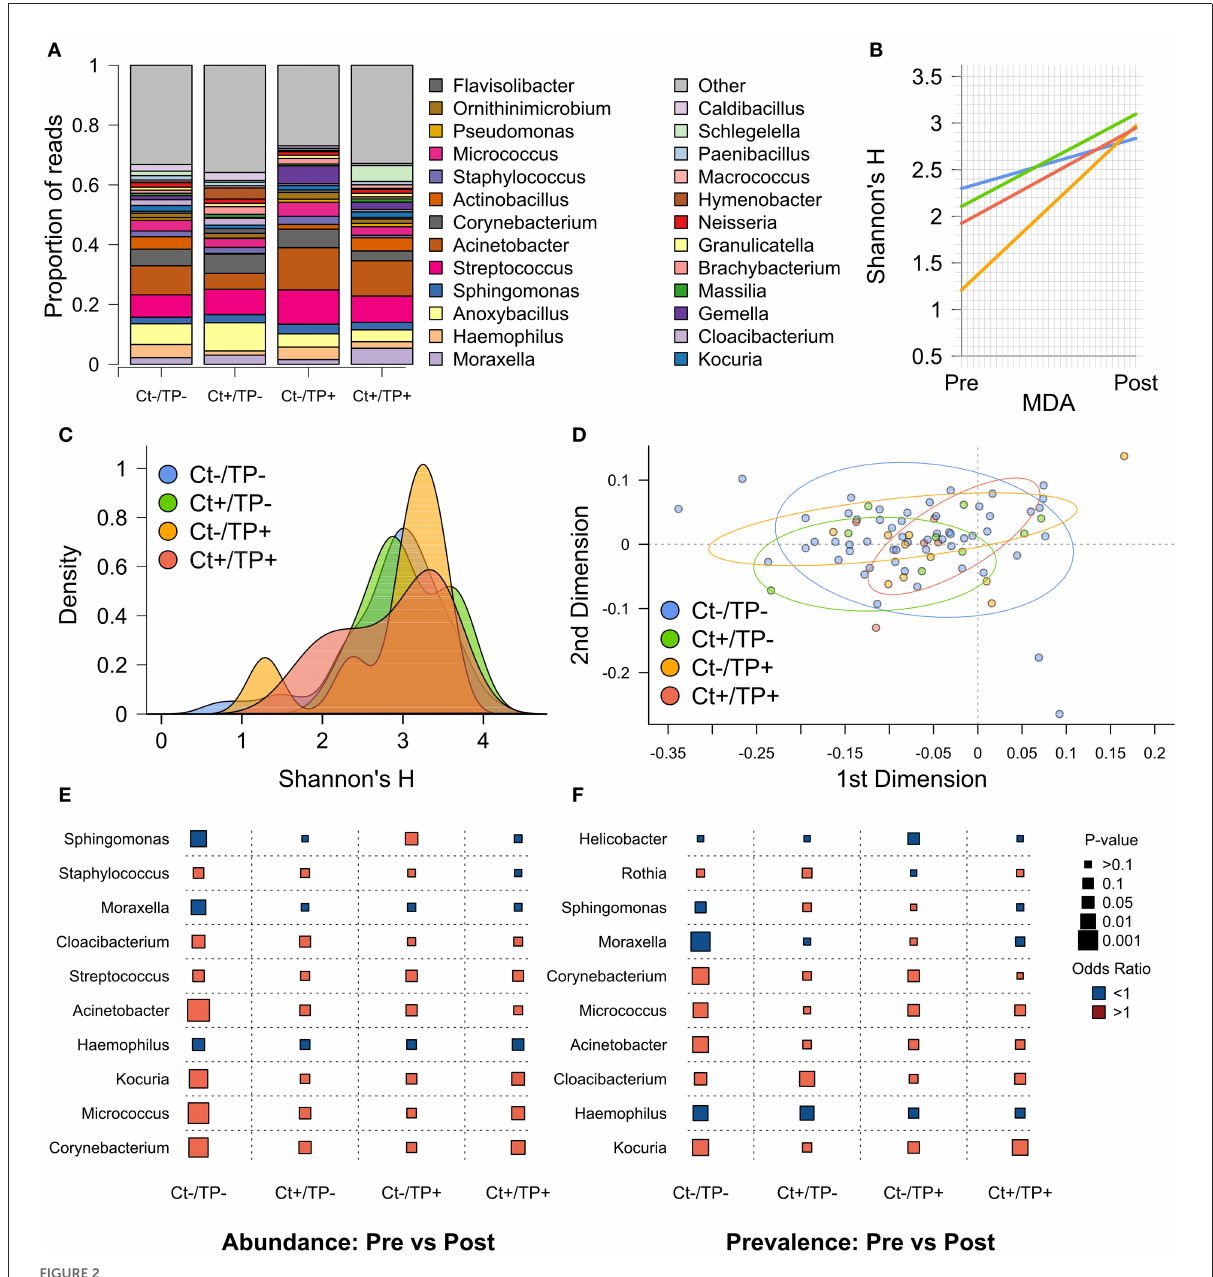
FIGURE2 Post-MDA ocular microbiome by pre-MDA Ct and TP status. (A) Genera with ≥ 1% relative abundance, all genera below < 1% are grouped as “Other.” (B) Change in Shannon’s H from pre- to post-MDA. (C) Alpha diversity, measured by Shannon’s H, by group. (D) PCA of beta diversity, measured by weighted uniFrac distance. (E) Logistic regression comparing genera abundance from pre- to post-MDA for indicated clinical groups, odds ratio (color of points; red > 1, blue < 1) and p -value (size of points). (F) Logistic regression comparing genera prevalence (read count > 0) from pre- to post-MDA for indicated clinical